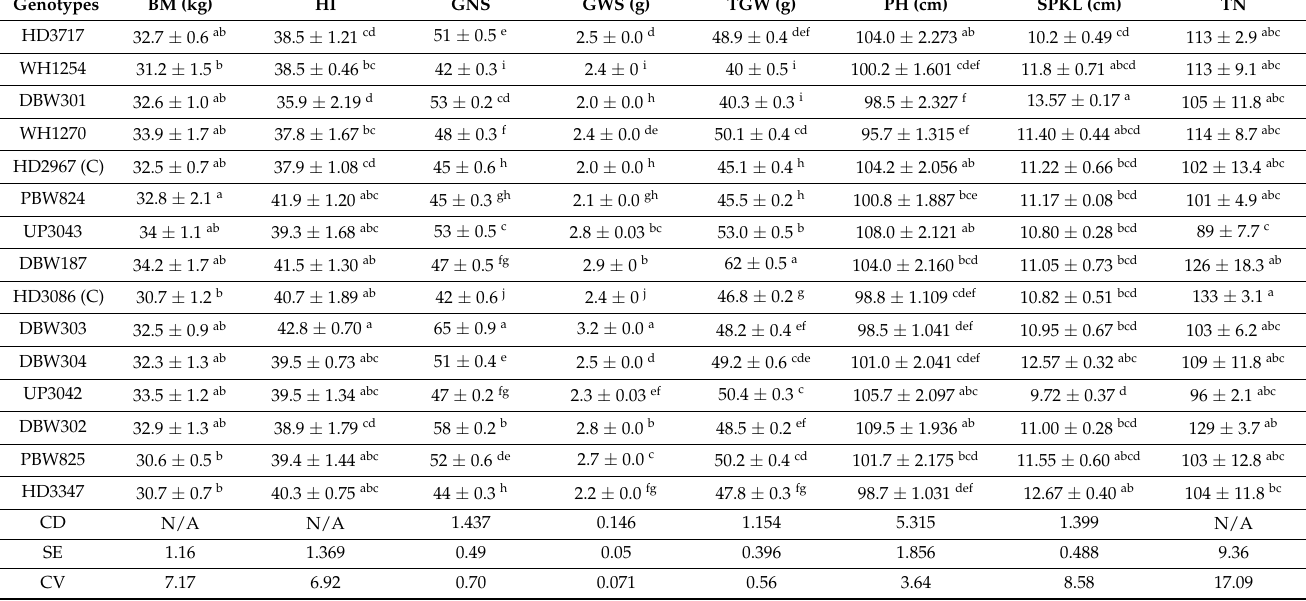
Table 3. Various yield associated traits recorded during HYPT.